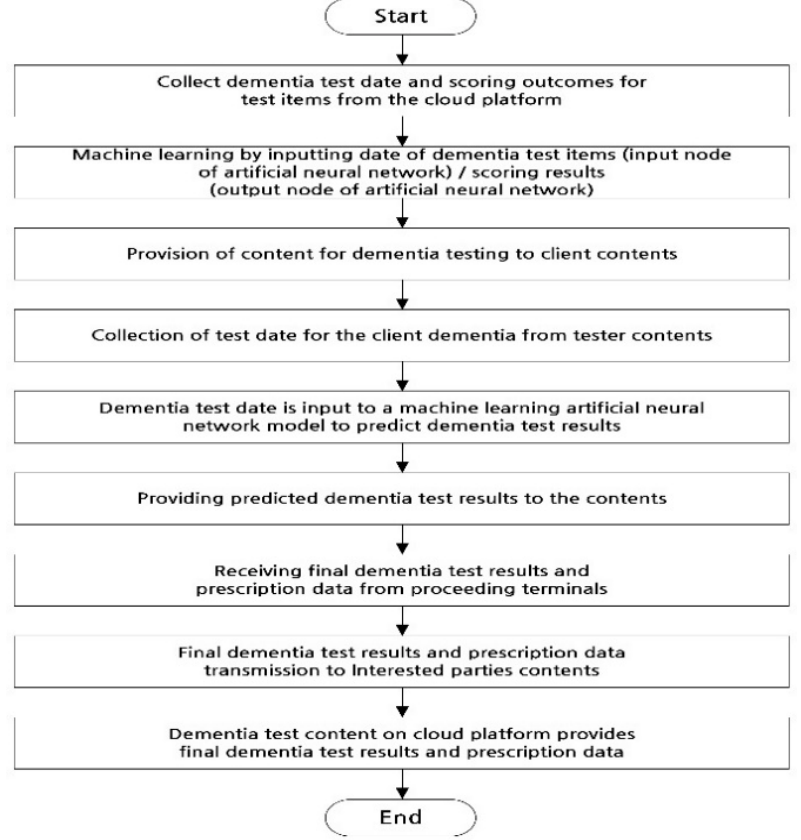
Figure 5. Flow chart of the component block diagram of the dementia testing management server using machine learning.